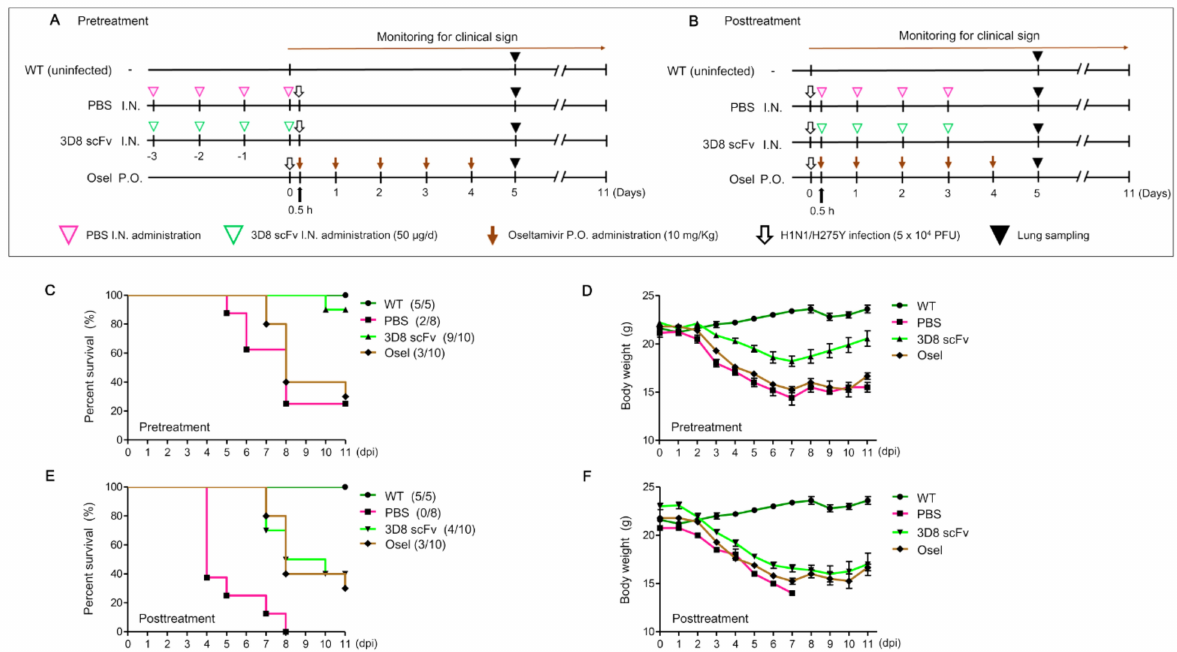
Figure 3. In vivo assessment of antiviral effects of 3D8 scFv against H1N1/H275Y infection. ( A , B ) Schematic diagram of 3D8 scFv treatment and H1N1/H275Y infection protocol. Mice were infected with H1N1/H275Y virus and pre/posttreated intranasally with 3D8 scFv (50 µ g/d) for 4 d. Oseltamivir (Osel) (10 mg/Kg) was orally administered (5 d consecutively). The clinical signs in the mice were observed for 11 d. The mice were euthanized (5 dpi) for lung sampling. ( C , E ) The survival rates of the infected mice. ( D , F ) The mean body weight of the infected mice. (WT n = 5, PBS pre/posttreatment n = 8, 3D8 scFv pre/posttreatment n = 10, Oseltamivir administration n =